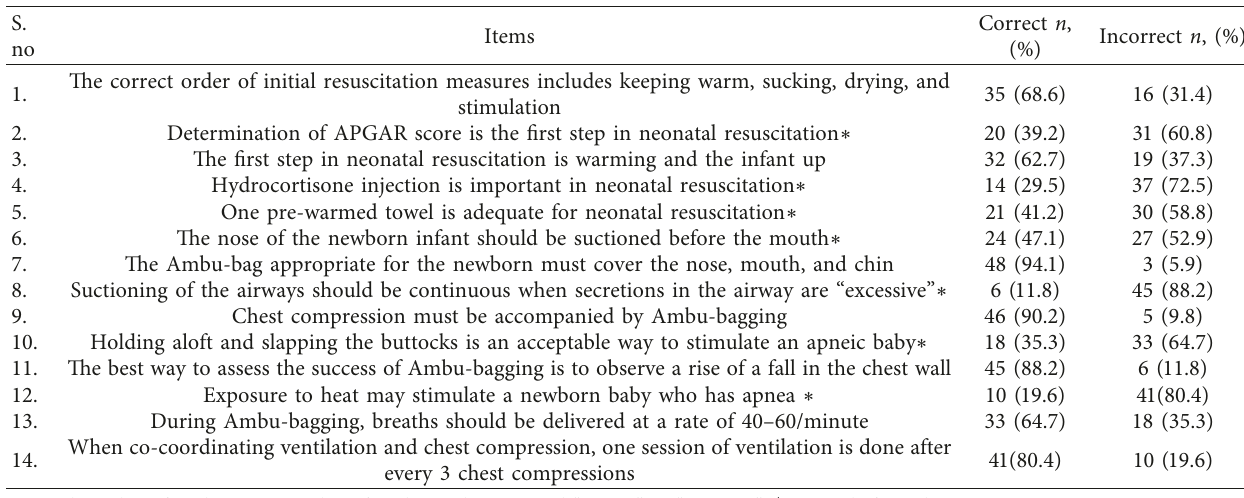
Table 2: Pre-intervention knowledge of appropriate decisions and actions in neonatal resuscitation of undergraduate final-year anesthesia students ( N �